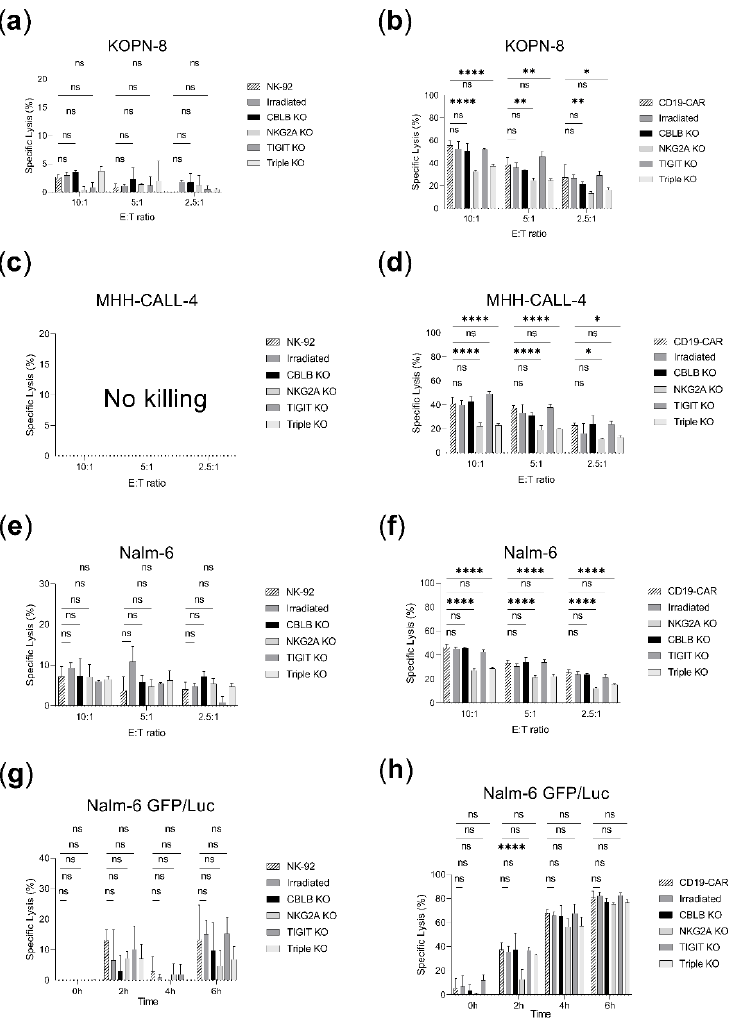
Figure 5. Cytotoxicity assays in B-ALL cell-lines comparing the cytotoxicity of parental NK-92 and CD19-CAR-NK-92 vs. irradiated, CBLB, NKG2A, TIGIT or triple knock-out cells. Specific lysis is shown as mean ± SD ( n = 3). Calcein assays were incubated for 2 h and several effector-to-target (E:T) ratios were employed: 10:1, 5:1, 2.5:1. Luciferase assays were studied for a time span of 6 h at 5:1 E:T ratio. ( a ) NK-92 cell lines vs. KOPN-8 calcein assay. ( b ) CD19-CAR-NK-92 cell lines vs. KOPN-8 calcein assay. ( c ) NK-92 cell lines vs. MHH-CALL-4 calcein assay did not display cytotoxicity in the tested conditions (no killing). ( d ) CD19-CAR-NK-92 cell lines vs. MHH-CALL-4 calcein assay. ( e ) NK-92 cell lines vs. Nalm-6 calcein assay. ( f ) CD19-CAR-NK-92 cell lines vs. Nalm-6 calcein assay. ( g ) NK-92 cell lines vs. Nalm-6 GFP/Luc luciferase assay. ( h ) CD19-CAR-NK-92 cell lines vs. Nalm-6 GFP/Luc luciferase assay. * p < 0.05; ** p < 0.01; **** p < 0.0001; ns, non-significant ( p >